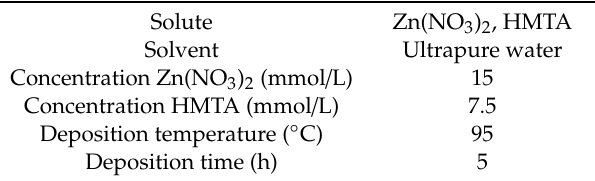
Table 2. Deposition conditions of ZnO nanorods.